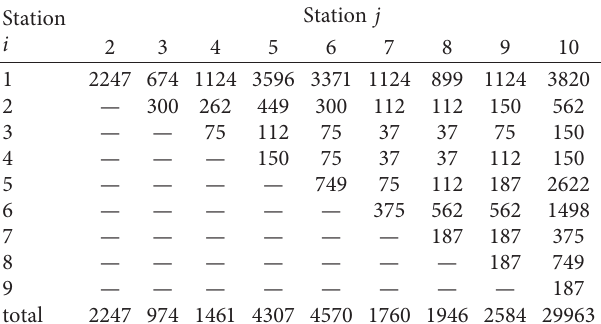
Table 4: Daily average OD passenger flow data of Lanzhou-Xi’an high-speed railway corridor.